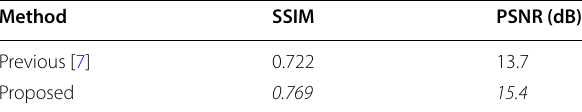
Table 1 Quantitative evaluation of the appearance of the generated free viewpoint images